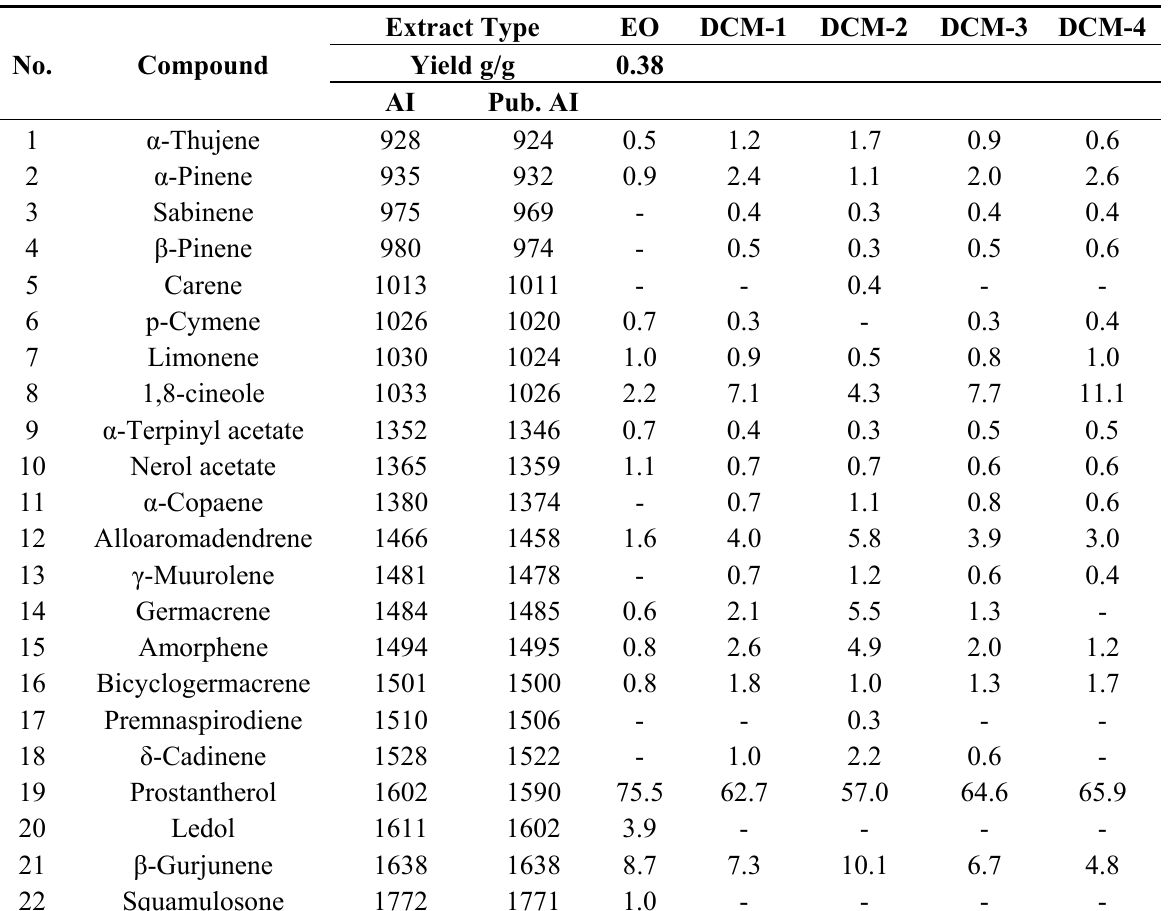
Table 1. Percentage chemical character determined by Gas Chromatography-Mass Spectroscopy (GC-MS) of essential oil (EO) from Prostanthera centralis and percentage chemical character of volatiles extracted from plants 1–4 using dichloromethane (DCM1–DCM4). Compounds are numbered sequentially according to rank by arithmetic index (AI) and the EO % yield (g/g) is also included. Published values of AI (Pub. AI) are from Adams